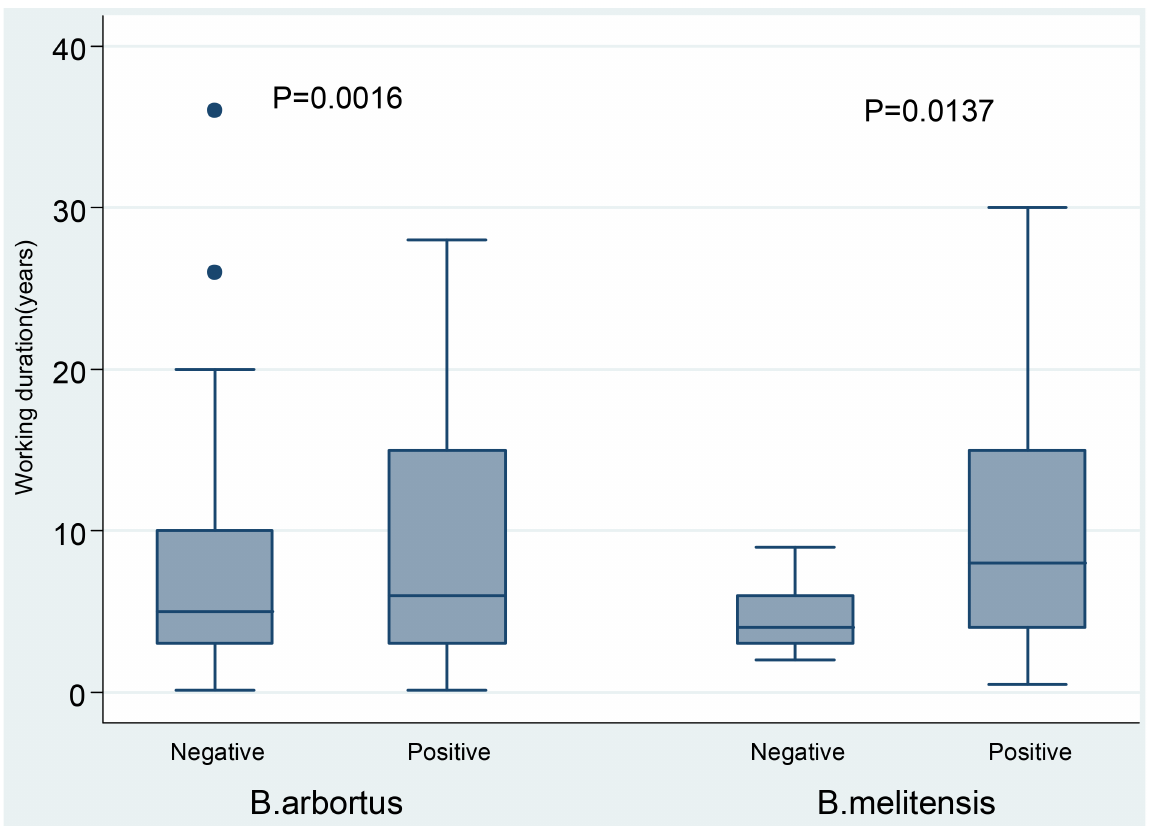
Fig 1. Boxplot showing the median work duration (years) between Brucella spp. seropositive and seronegative